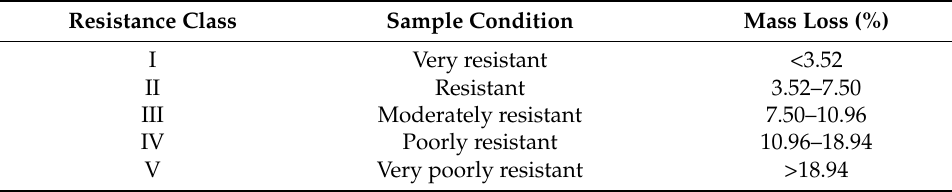
Table 2. Resistance class against subterranean termite